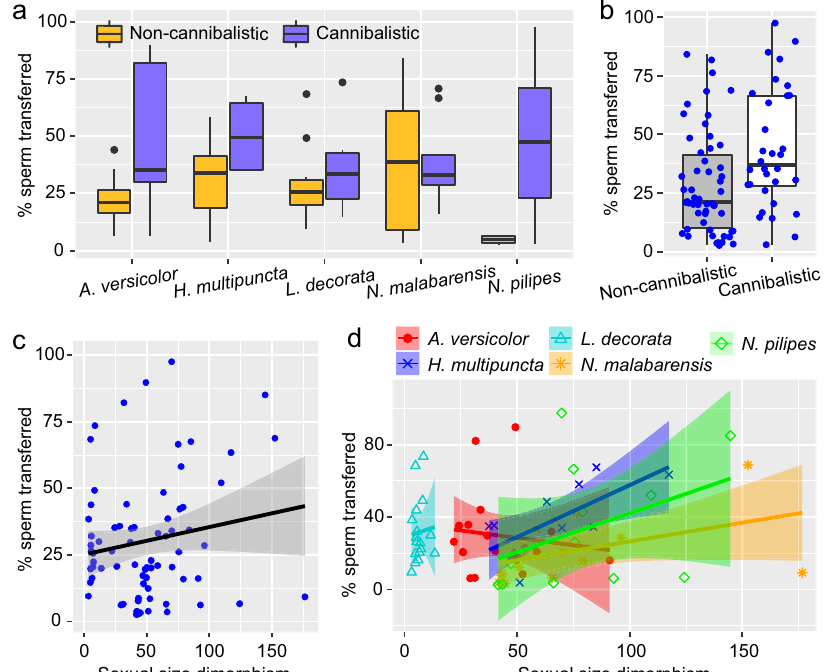
Fig. 3 Effects of species, sexual cannibalism and sexual size dimorphism on the percentage of sperm transferred. a The percentage of sperm transferred when a male mated with a cannibalistic or non-cannibalistic female in the fi ve species. b Overall, males transferred signi fi cantly more sperm if a female was cannibalistic. c A positive correlation between sexual size dimorphism and the percentage of sperm transferred across the fi ve species. d The more biased sexual size dimorphism, the more sperm were transferred in all species except in Argiope versicolor . COMMUNICATIONS BIOLOGY| (2022) 5:534